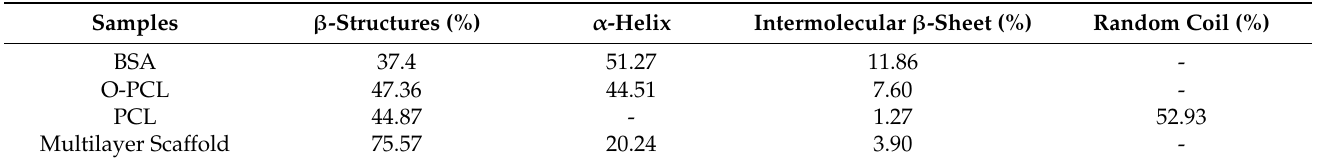
Table 3. Summary of relative areas (%) of secondary structural features of BSA identified via Gaussian deconvolution of the amide I band of adsorbed samples collected via